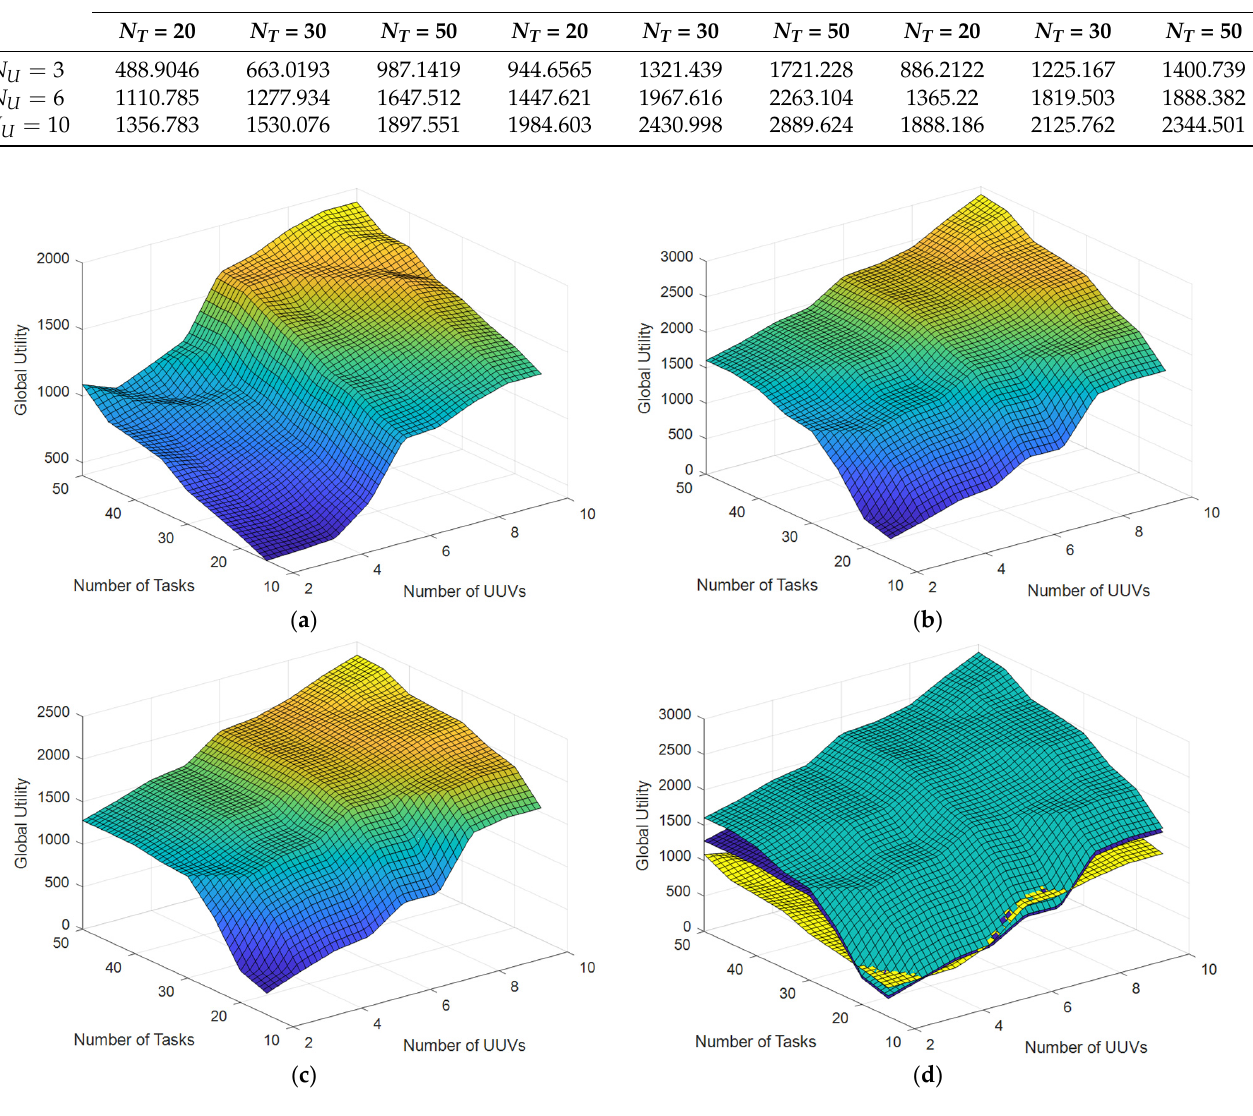
Figure 6. Global utility with different numbers of UUVs and tasks. ( a ) Original CBBA (without communication range constraint). ( b ) ECBBA (without communication range constraint). ( c ) DECBBA (with communication range constraint). ( d ) Comparison of Three Algorithms.